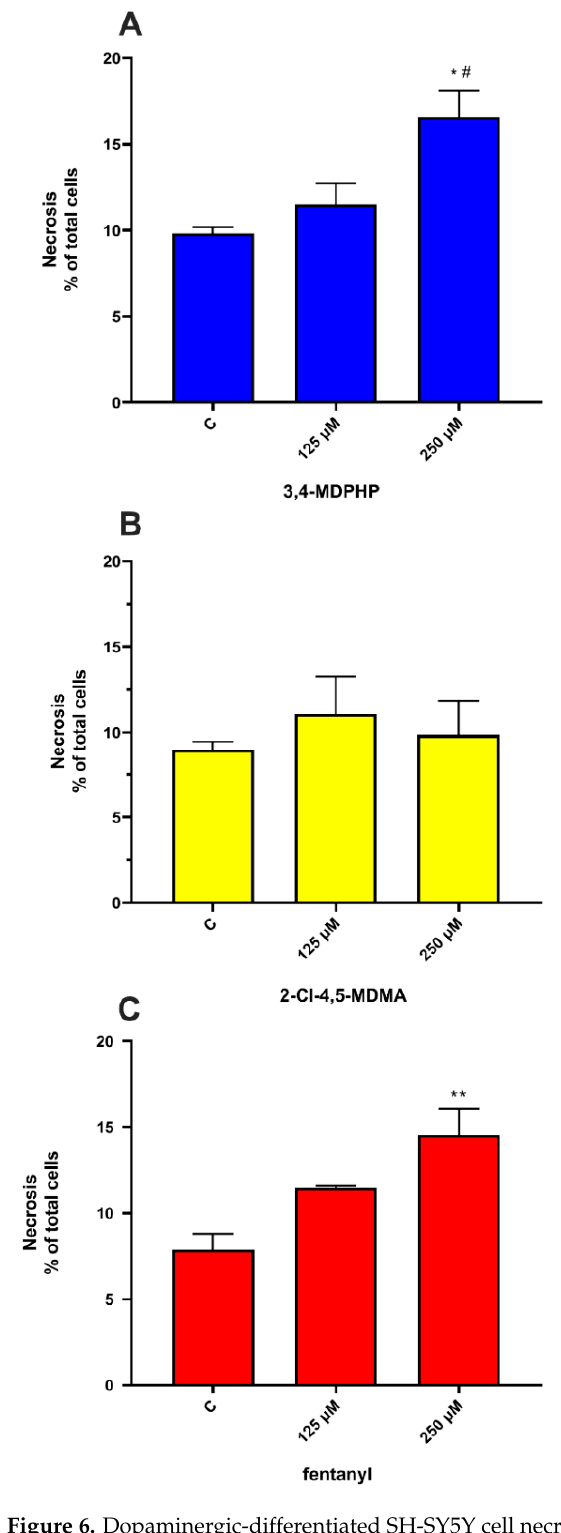
Figure 6. Dopaminergic-differentiated SH-SY5Y cell necrosis is induced by 3,4-MDPHP and fentanyl but not 2-Cl-4,5-MDMA. SH-SY5Y cells were exposed to 125 or 250 µ M of 3,4-MDPHP ( A ), 2-Cl-4,5-MDMA ( B ), and fentanyl ( C ) for 24 h. Data, expressed as percentage of total cells, represent mean ± SEM from three independent experiments with three replicates for each concentration of the compounds. One-way ANOVA followed by Tukey’s post-hoc, * p < 0.05, ** p < 0.01 compared to its respective control, # p < 0.05 compared to 125 µ M of 3,4-MDPHP.